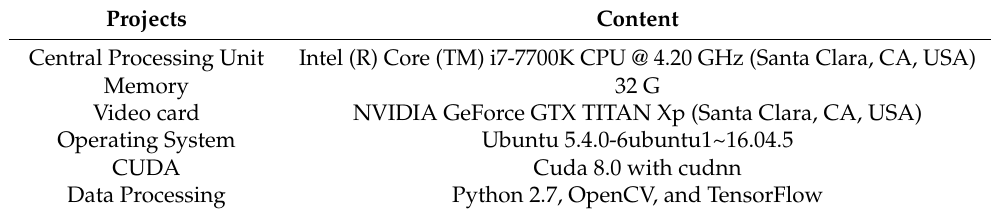
Table 1. Machine configuration information